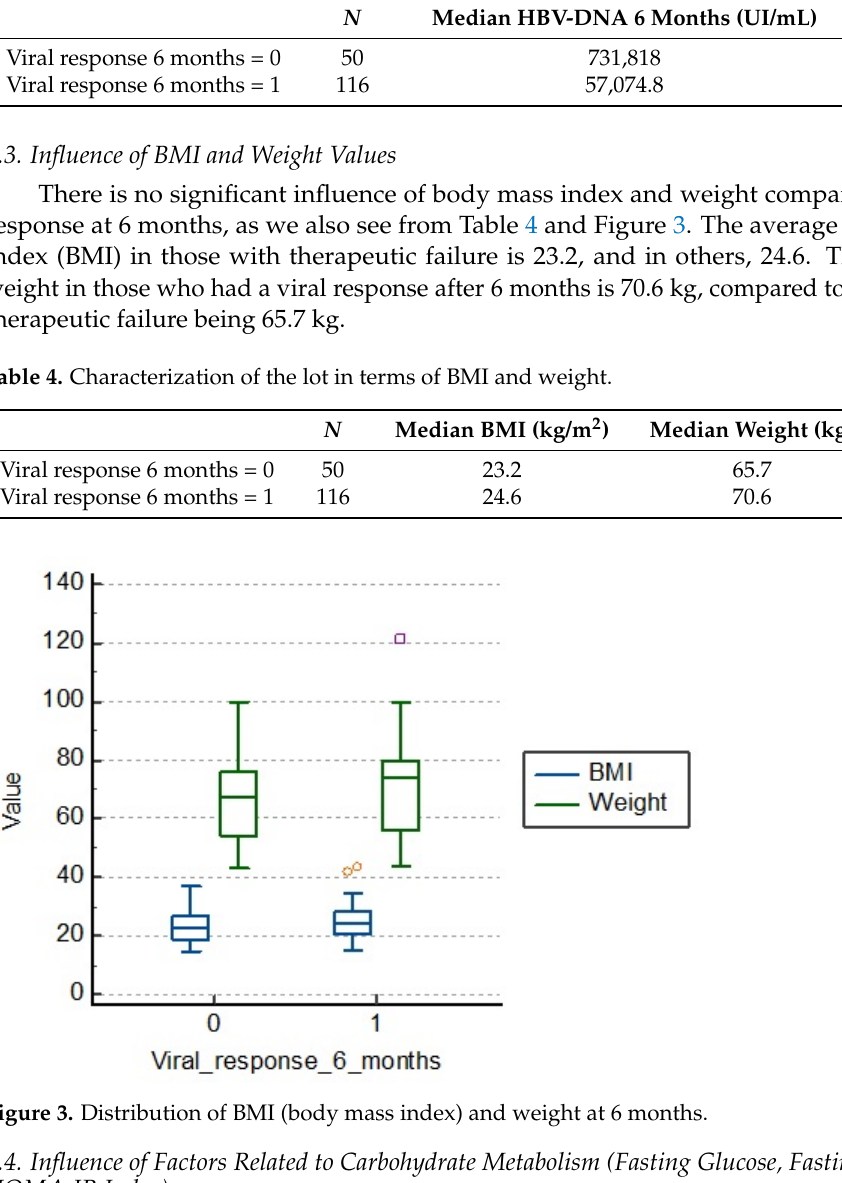
Table 3. Viremia at 6 months. Figure 2. Distribution of viremia at 6 months. HBV: hepatitis B virus.